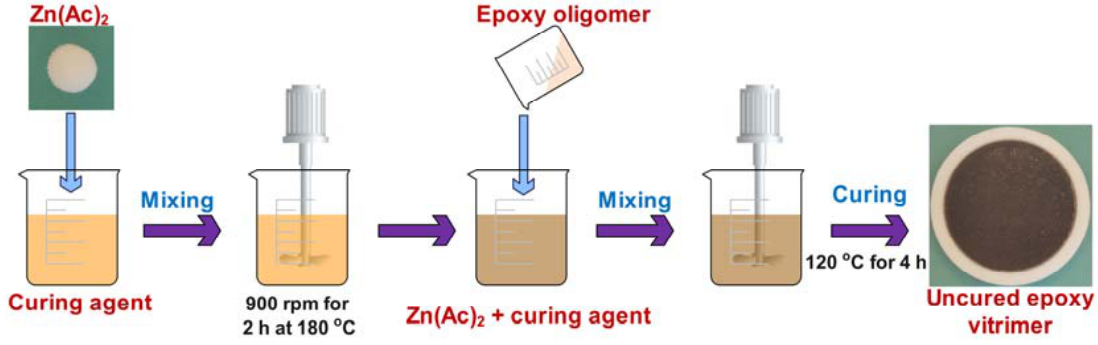
Figure 1. Schematic presentation for the preparation of epoxy vitrimer.